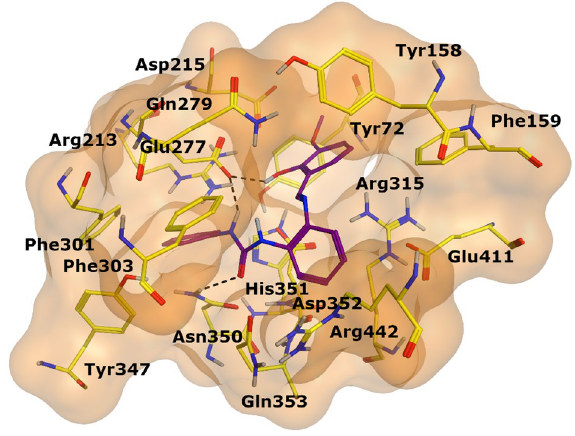
Figure 5. The binding mode of most active compound ( 3u ) is shown in the active site of enzyme. 3u is displayed in purple stick model, interacting residues are depicted in yellow stick model and Hydrogen bonds are shown in black dotted